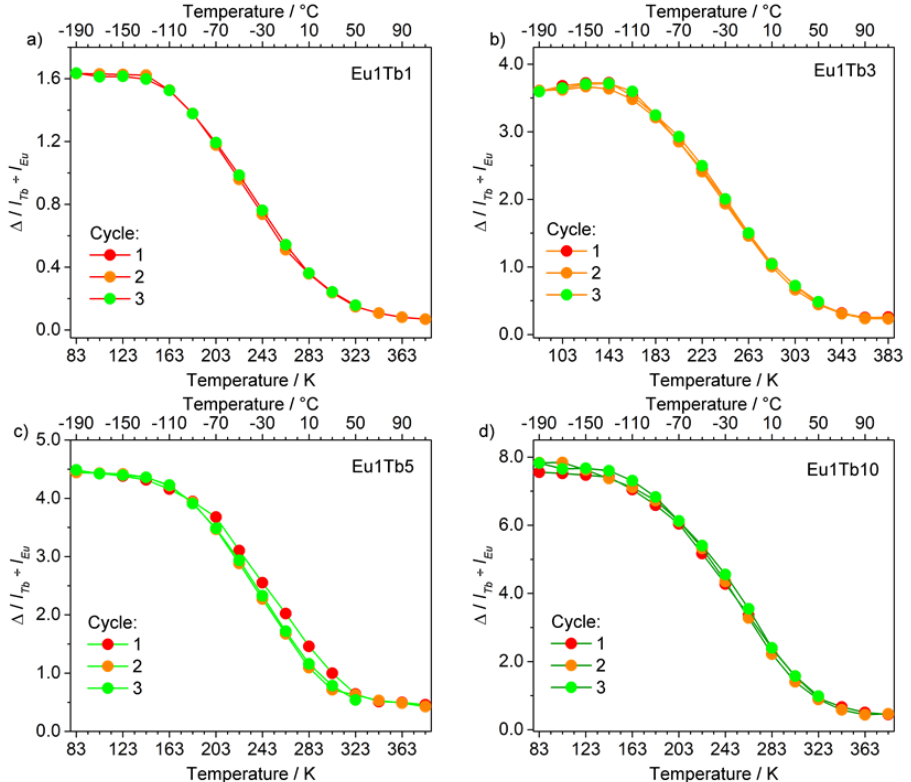
Figure 9. Heating/freezing cycles for samples ( a ) Eu1Tb1 , ( b ) Eu1Tb3 , ( c ) Eu1Tb5 , and ( d ) Eu1Tb10 . λ exc = 320 nm.